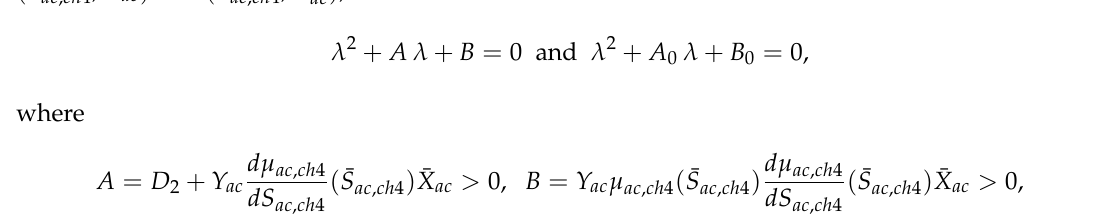
Figure 5. Eigenvalues of ∆ ( 3 ) evaluated at ( ¯ S su , ¯ S aa , ¯ X suaa ) for D 1 ∈ ( D solid circle on the horizontal axis denote D